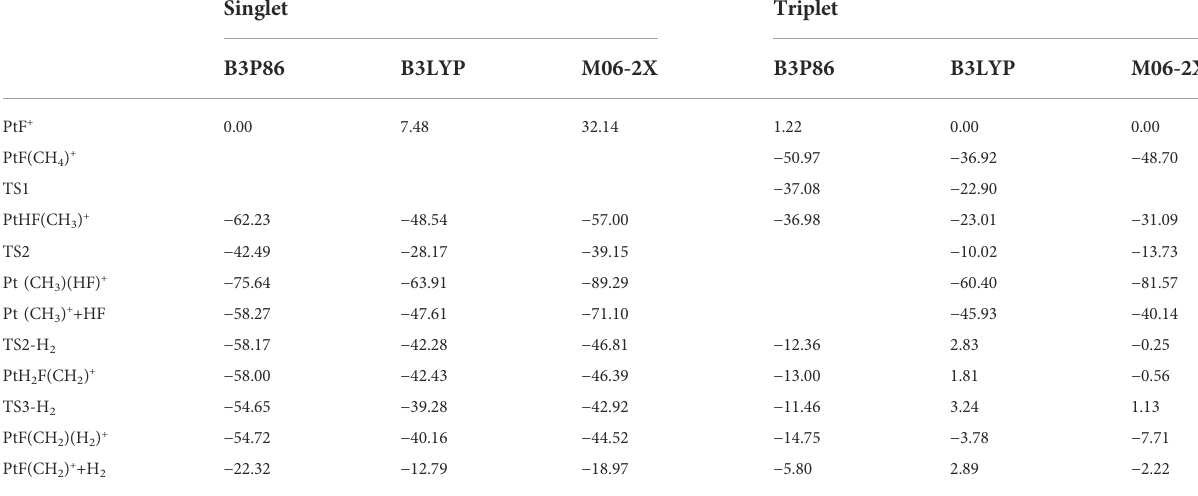
TABLE 1 Calculated relative energies (kcal/mol) of stationary points on the potential energy surfaces of the reaction PtF + and CH 4 in the singlet and triplet states in three methods. Singlet Triplet B3P86 B3LYP M06-2X B3P86 B3LYP M06-2X PtF +